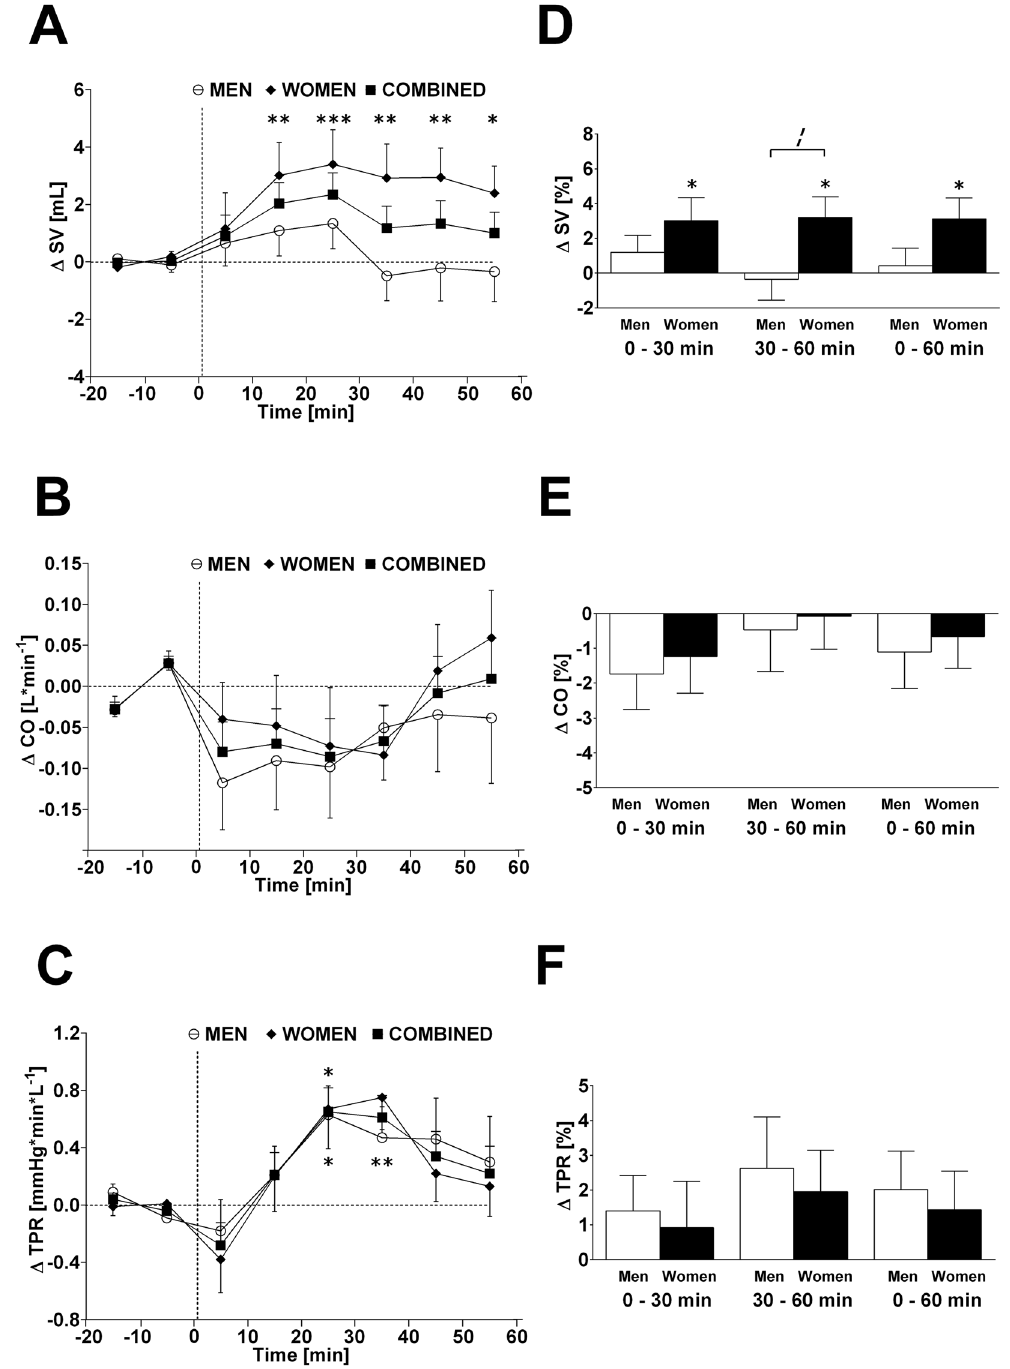
Figure 2. Left panels A–C: Time course of changes ( Δ ) from baseline in stroke volume (SV), cardiac output (CO) and total peripheral resistance (TPR), respectively. Open circle ( ○ ) = men; closed diamond ( ♦ ) = women; closed square ( ■ ) = combined men and women. Right panels D–F represent mean percentage changes in SV, CO and TPR relative to baseline. Time 0 denotes four minutes after the water drink with calculating a subsequent average over the following 30 minutes, 30 to 60 minutes, and 0 to 60 minutes post-drink, respectively, which were subtracted from each baseline level and presented as deltas. * P < 0.05, ** P < 0.01 and *** P < 0.005 statistically significant differences over time from baseline values (left and right panels). ¦ P < 0.05 statistically significant difference between men and women at 30–60 min post-drink (right panel). All values are reported as means ±